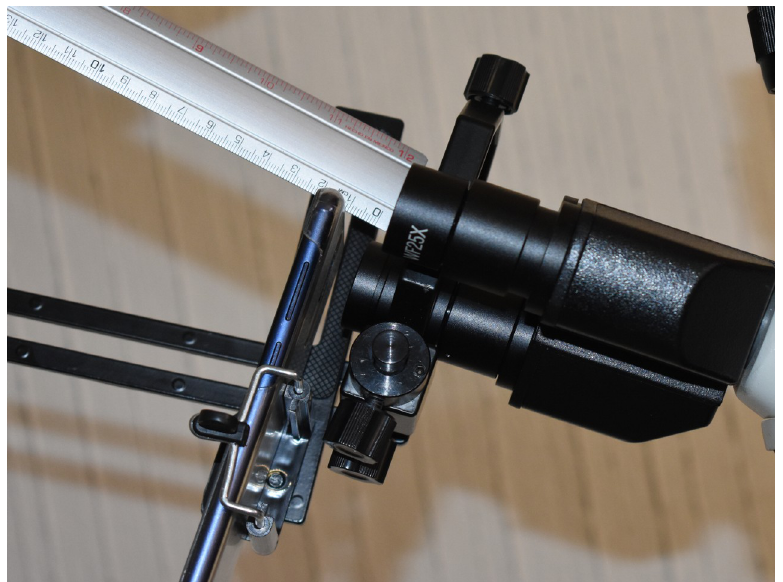
Fig 5. Distance between the microscope’s ocular and the smartphone